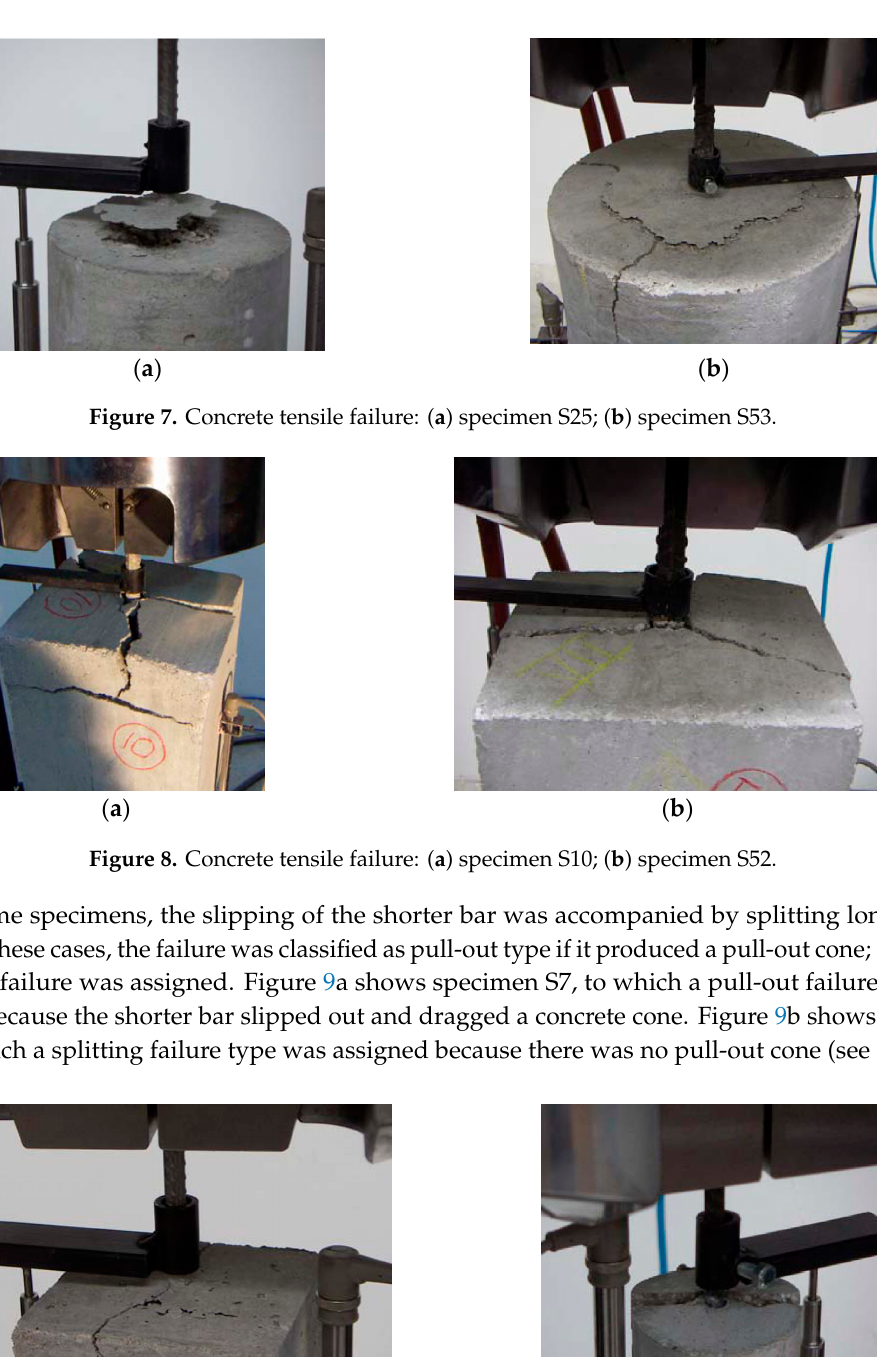
Figure 9. Specimens exhibiting pull-out failure accompanied by splitting failure: ( a ) specimen S7; ( b ) specimen S42.